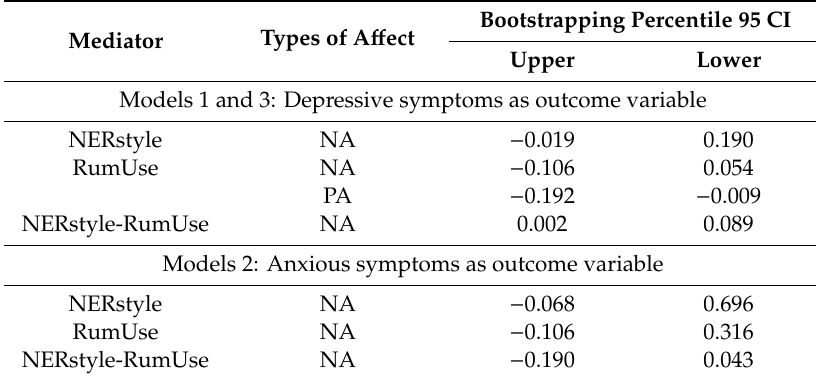
NA = negative a ff ect, PA = positive a ff ect, NER style = negative emotion regulation style, RumUse = the relative frequency of rumination